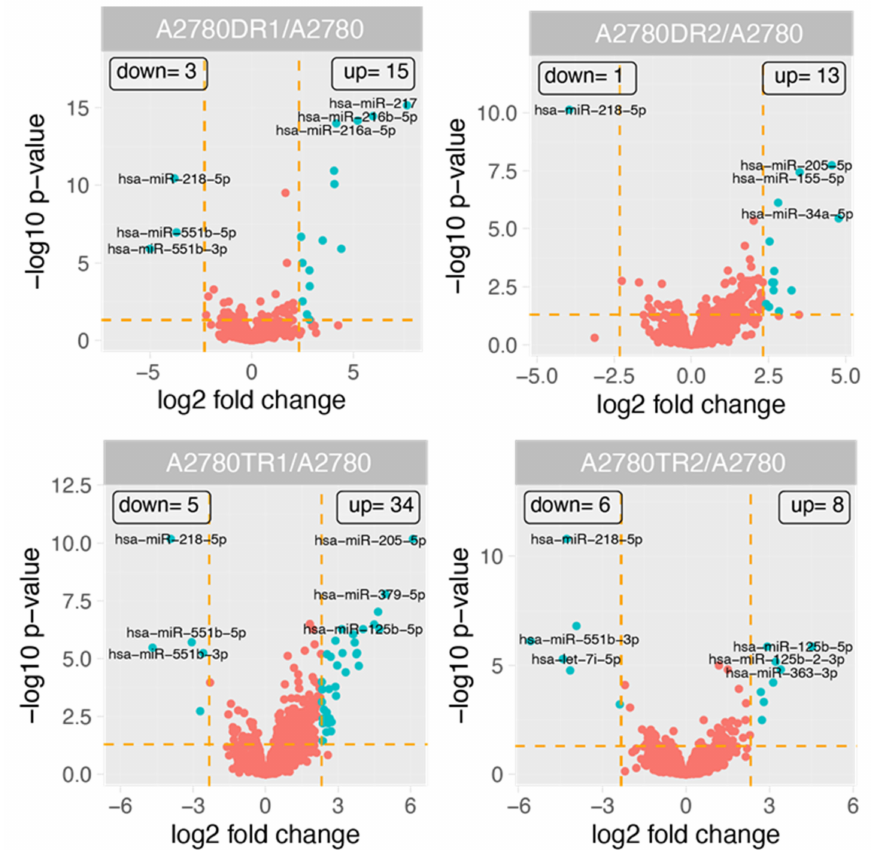
Figure 1. Volcano plots representing the miRNA with at least 5-fold upregulated or downregulated expression levels (green dots) in drug-resistant cell line, compared with A2780 cell line. Red dots show miRNAs below the established cut-off criteria (|fold|> 5, p <